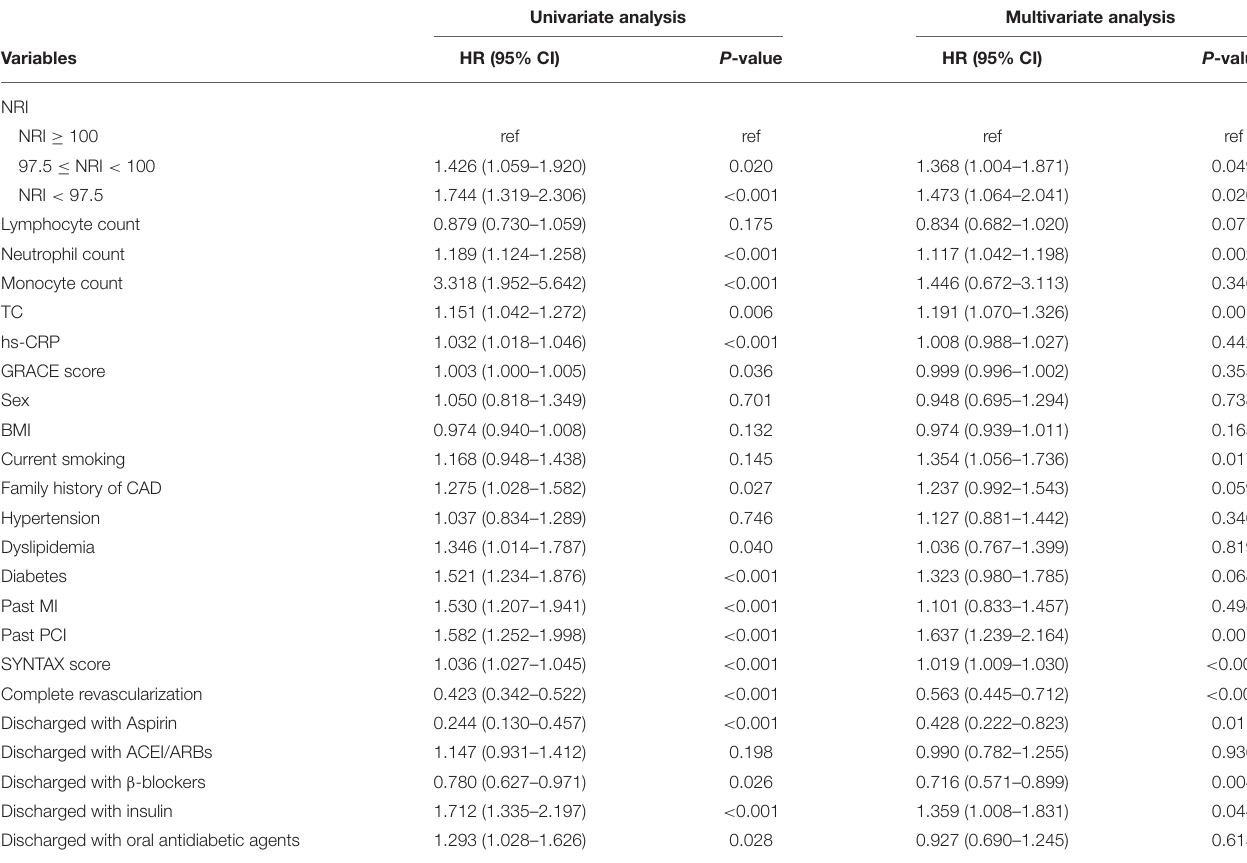
TABLE 3 | Relationship between MACE and NRI as a categorical variable in the overall population. Univariate analysis Multivariate